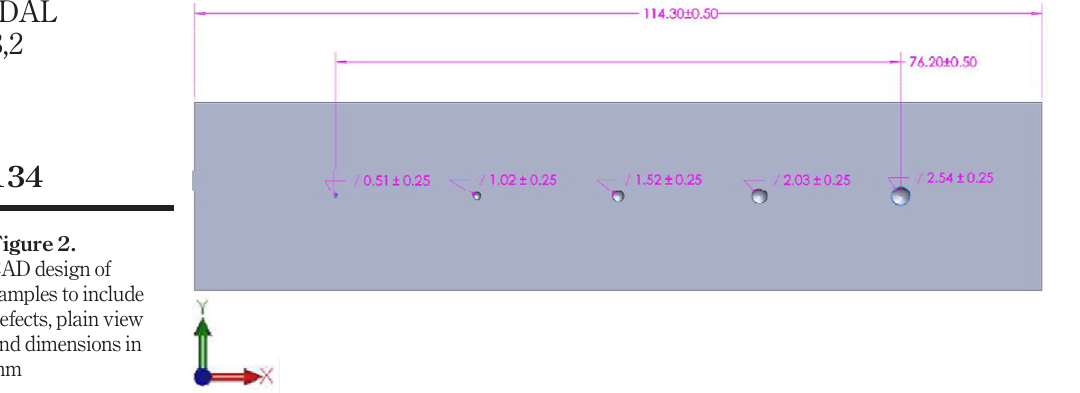
Figure 2. CAD design of samples to include defects, plain view and dimensions in mm